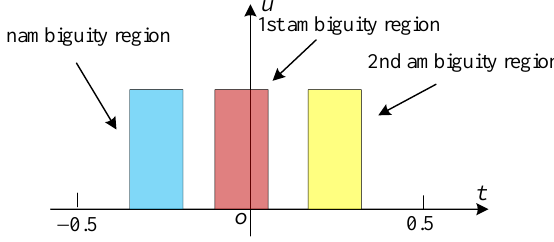
Figure 4. Echo data in a slow-time domain using the proposed method. main filters. Significantly, the essence of the proposed method is that the coupling term of